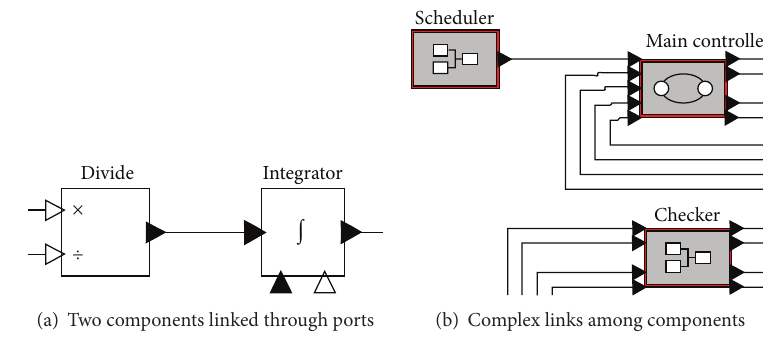
Figure 1: Two snippet models of linked components.